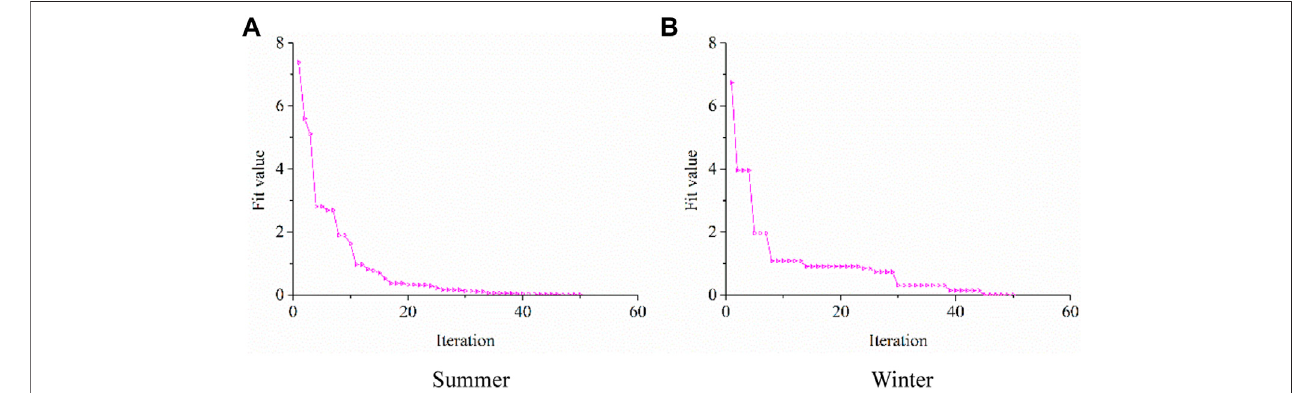
FIGURE 7 | Optimization experiment of fi re fl y algorithm.